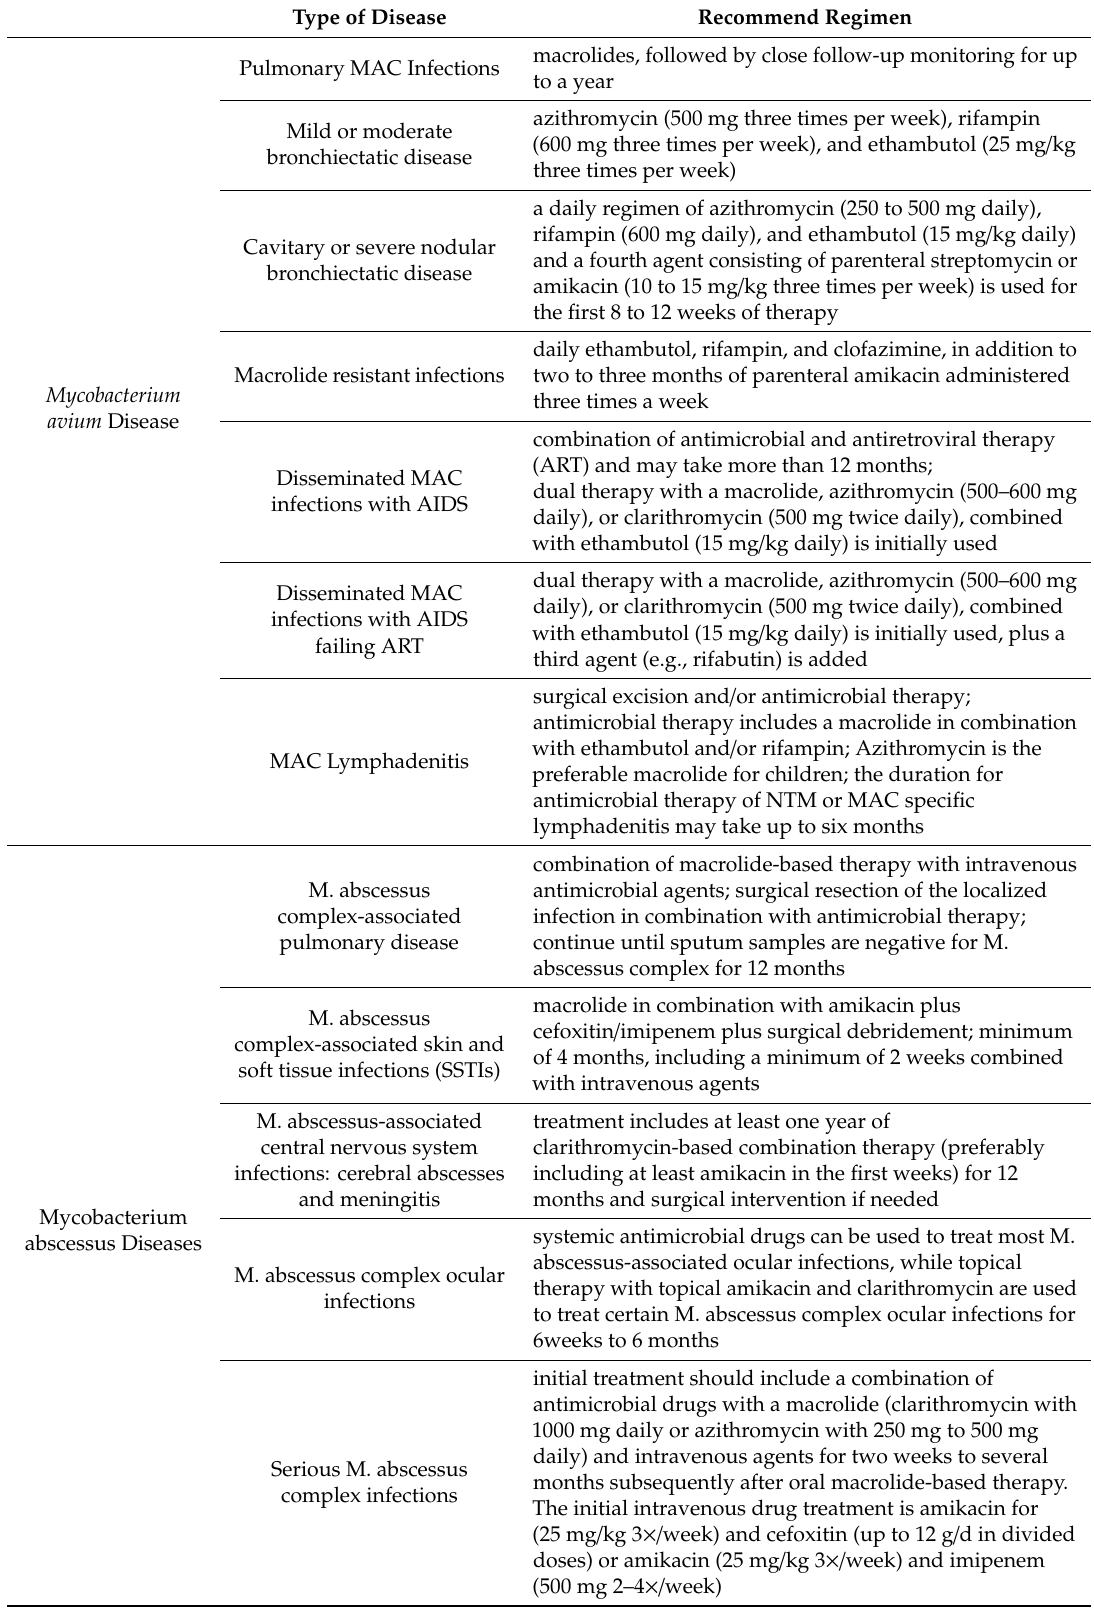
Table 2. Recommended treatment